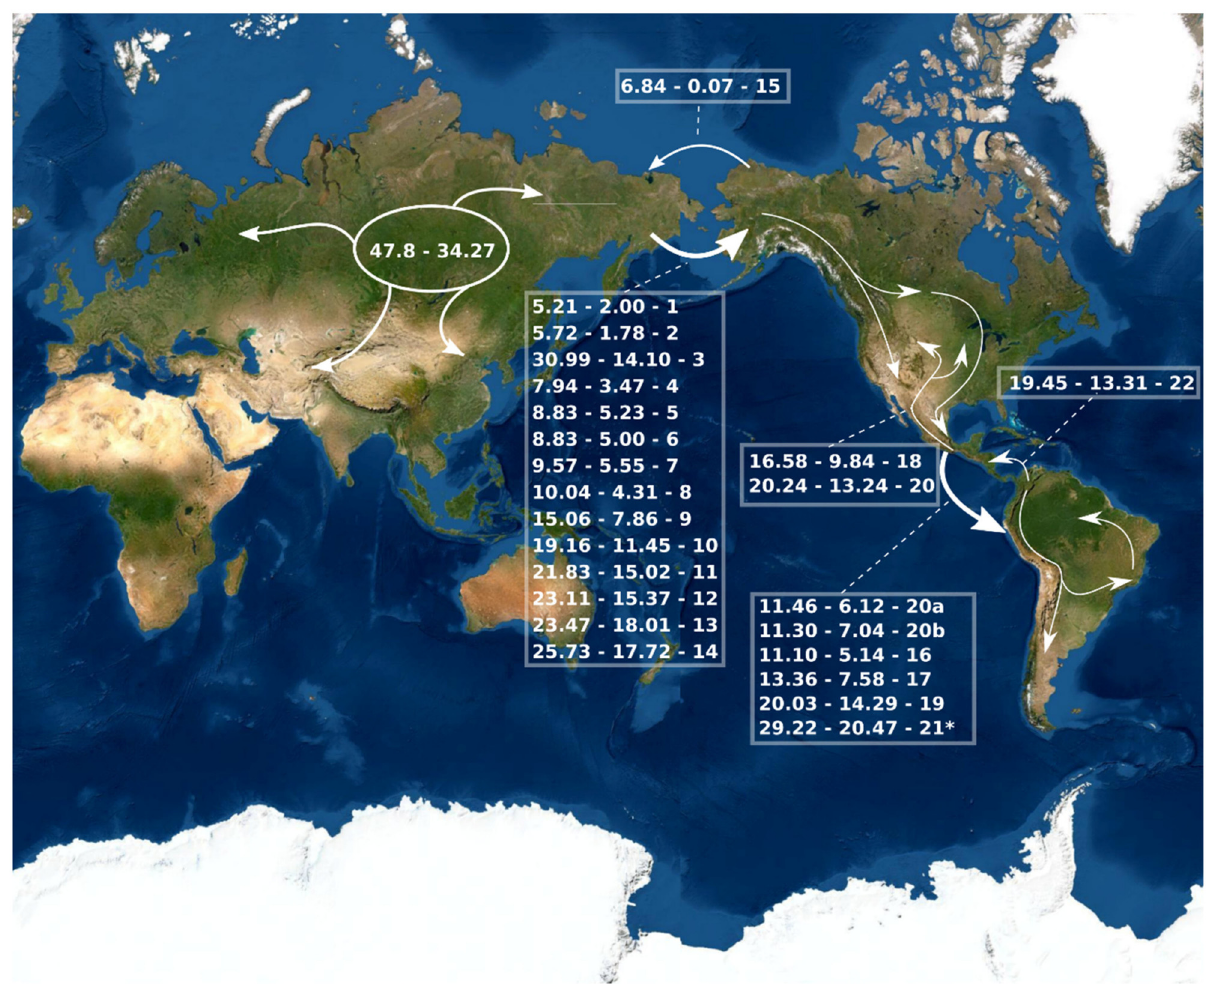
Figure 3. A simplified summary of the historical dispersal events inferred across Bombus lineages. The timing of these events is presented on HPD 95% (see Figure S2). The continuous arrows refer to the events found in the biogeographic analyses (see Figure 2, Figures S2 and S4–S6). The numbers (1–22) to the right of the date ranges are the events indicated in the phylogenies. * possible artefact of the